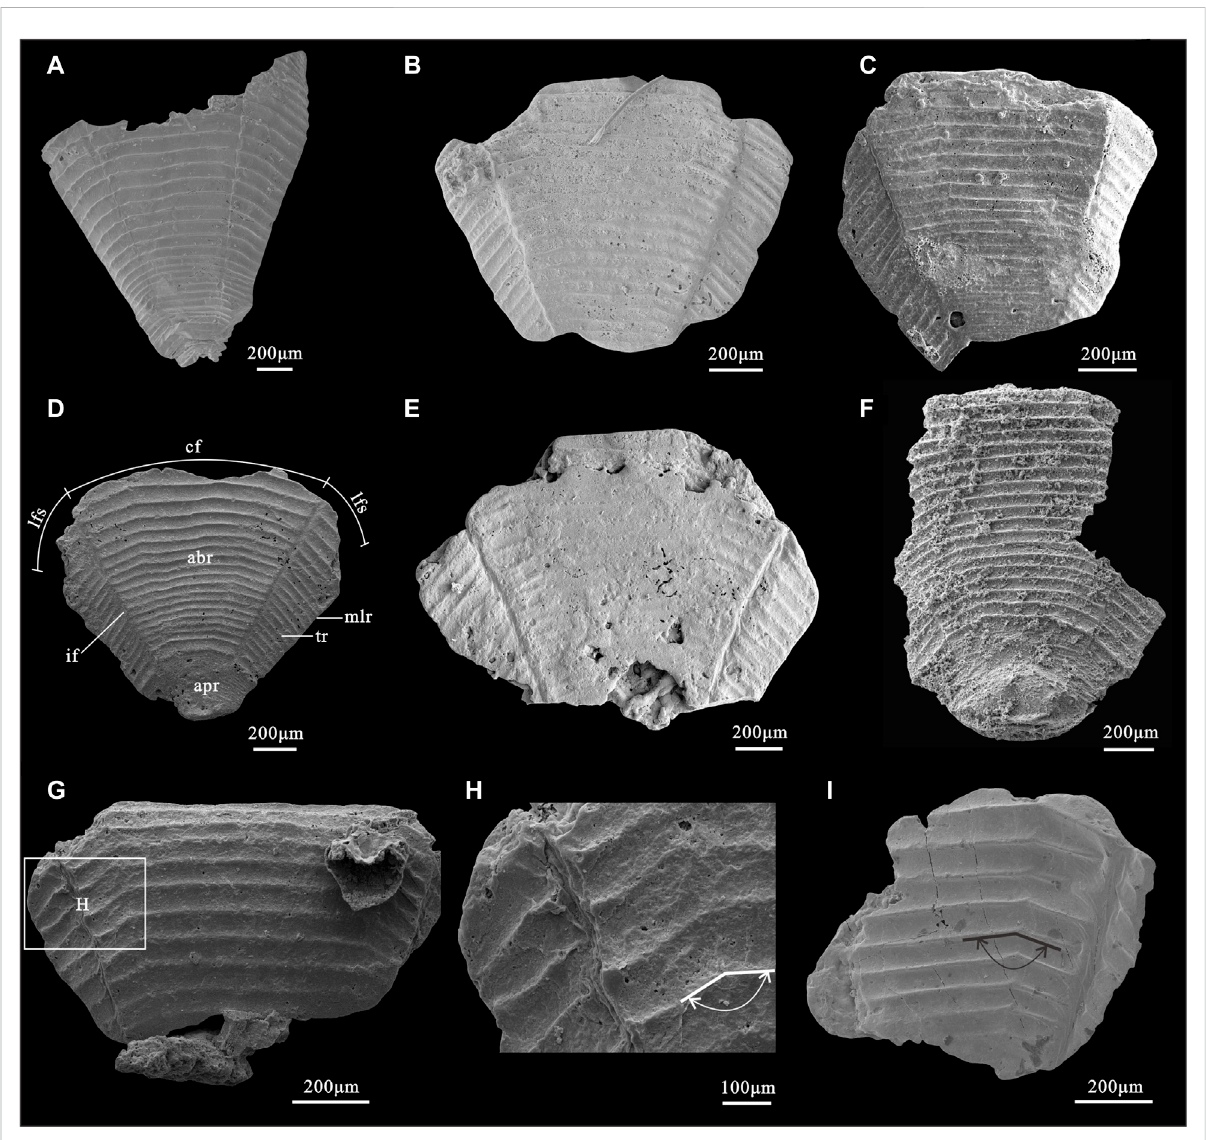
FIGURE 1 Hexangulaconularia formosa from the Kuanchuanpu Formation (Cambrian Fortunian Stage) of southern Shaanxi Province and Bed 2 of the Yanjiahe Formation (Cambrian Fortunian Stage) of western Hubei Province, China. (A – G,I) XX78-452, XX79-65, XX91-610, XX62-238, XX33-52, CUBar66-2, XX94-79, and XX96-250, respectively. (H) Magni fi ed view of an interfacial (longitudinal) furrow and transverse ribs (G) showing sharp, abapical bending ofthetransverse ribsnear theinterfacial furrow andtheabsence ofsuch afurrowalong thelocusofthepoints ofin fl ection of the transverse ribs. Abbreviations: abr=abapical region; apr=apical region; cf=central face; if=interfacial (longitudinal) furrow; lfs=lateral faces; mlr=marginal longitudinal ridge; tr=transverse